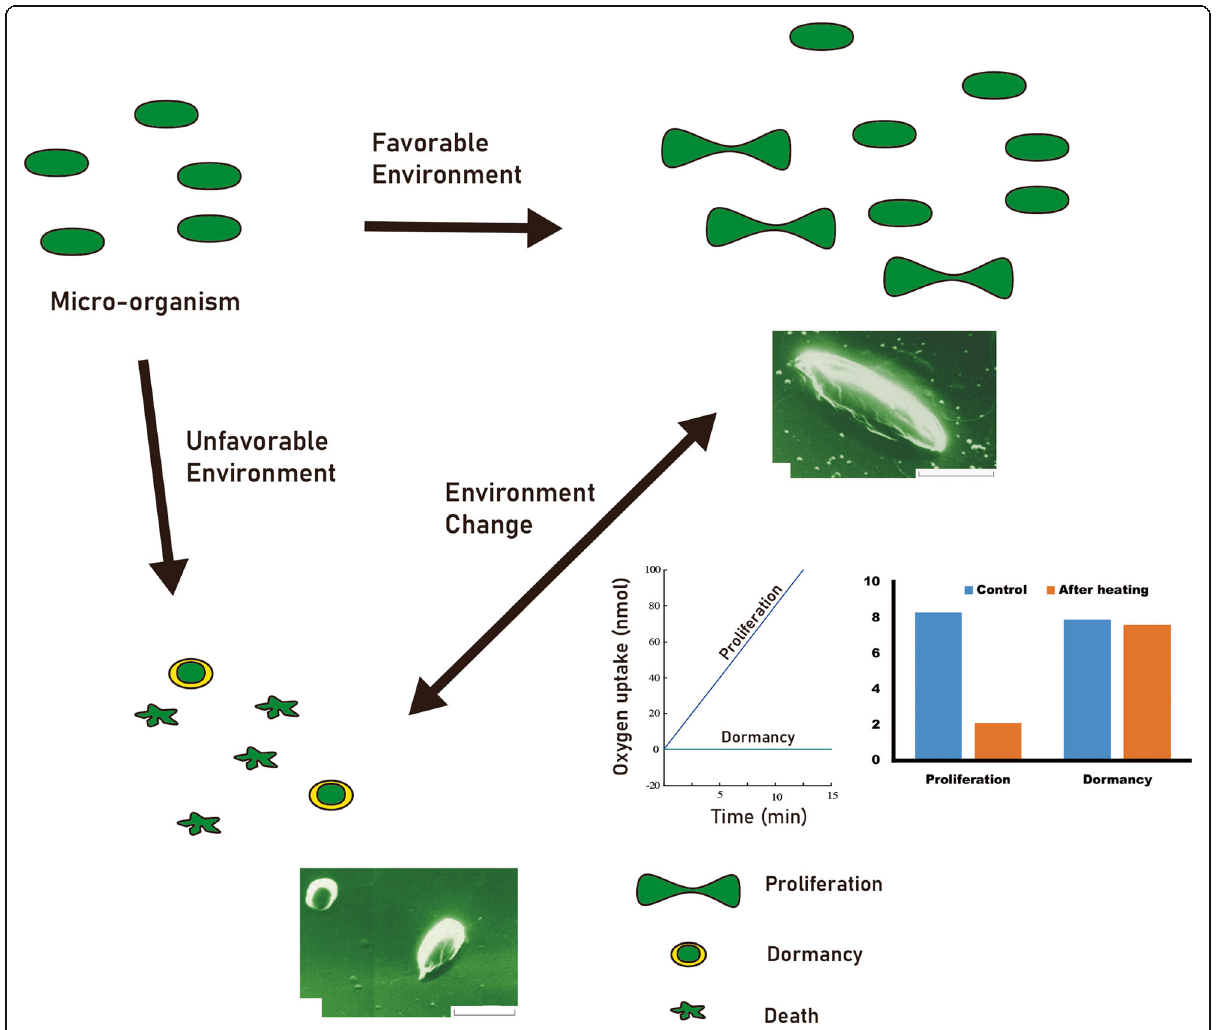
Fig. 1 The metabolism of micro-organism is dependent on outer environment. If the environment is unfavorable, many micro-organisms will stop their proliferation and undergo dormancy. The micro-organism in the dormancy does not use oxygen for its metabolism. In addition, it can survive after heating unlike the micro-organism under proliferation. The morphology of micro-organism is also different between proliferating one and dormant one (image clip and data were provided by Dr.